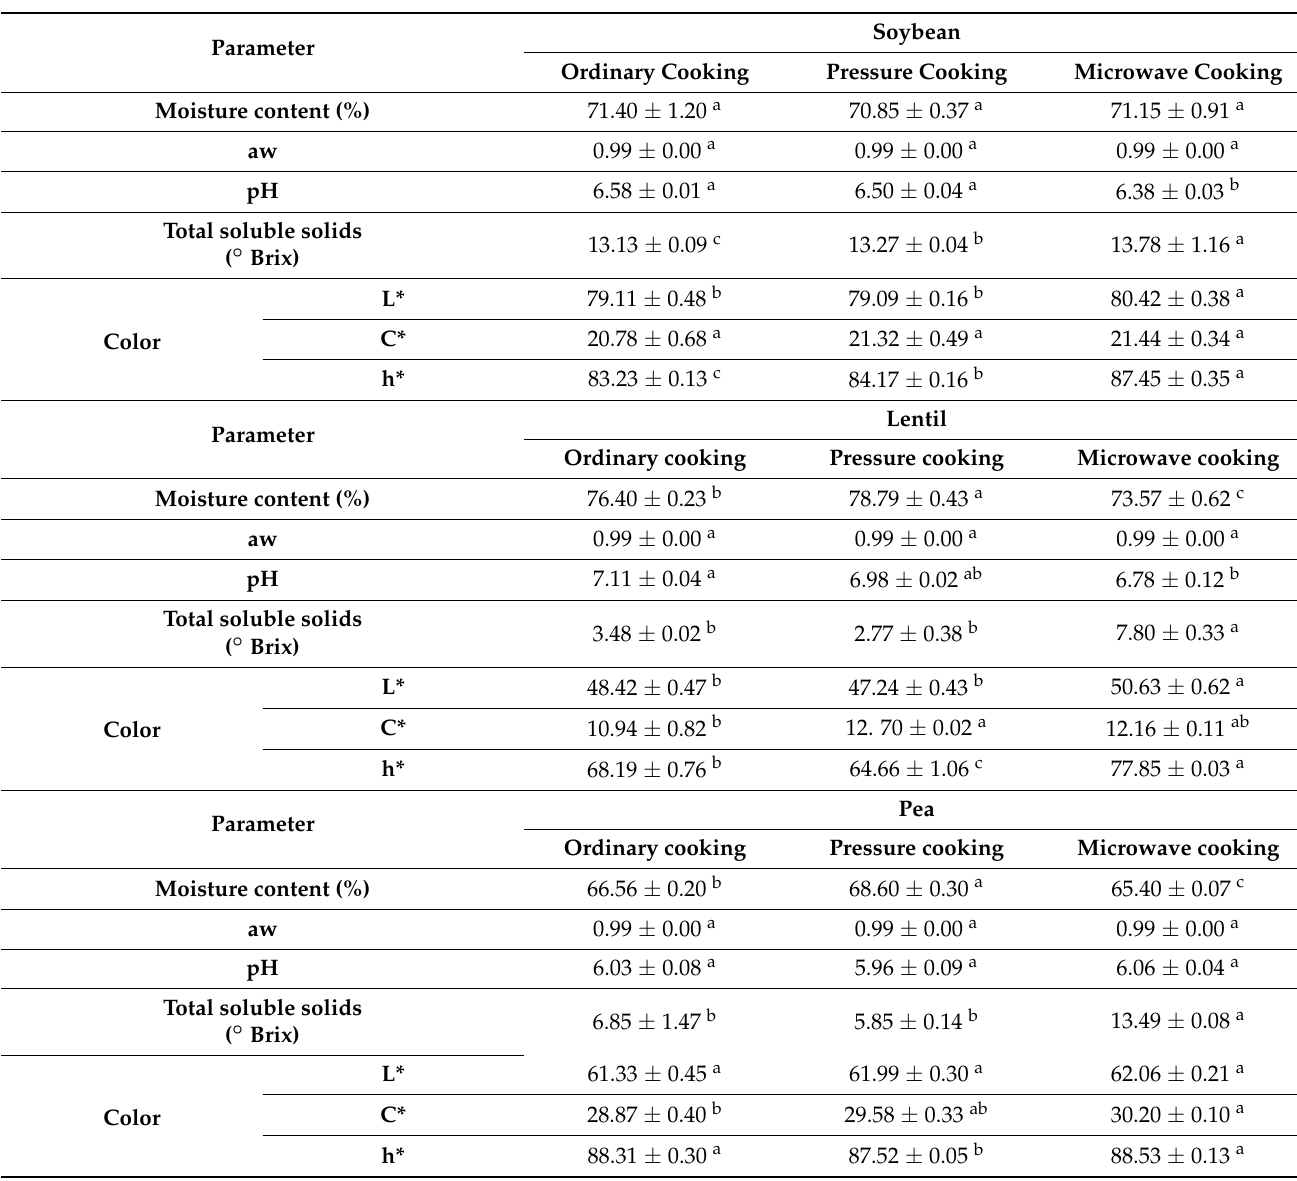
Table 1. Physicochemical parameters of legume pastes from soybean, lentil, and pea subjected to different cooking